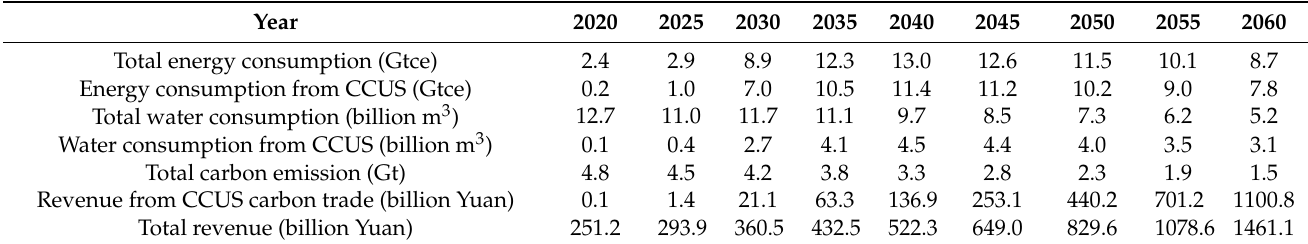
Table 18. ATPCC outputs of “Slow” portfolio for China’s coal power